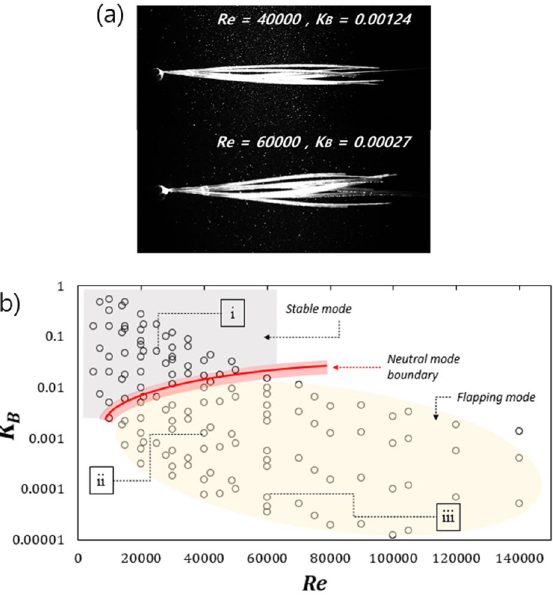
Figure 2. ( a ) Flapping sequence images of PENG deformation at each condition captured with a high-speed camera. ( b ) Regime map representing the PENG responses induced by the vortex